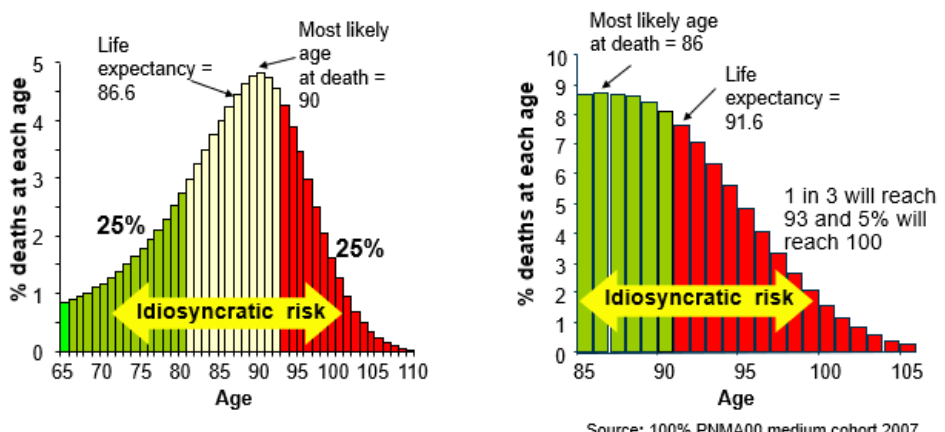
Figure 1. Expected distribution of death ages.